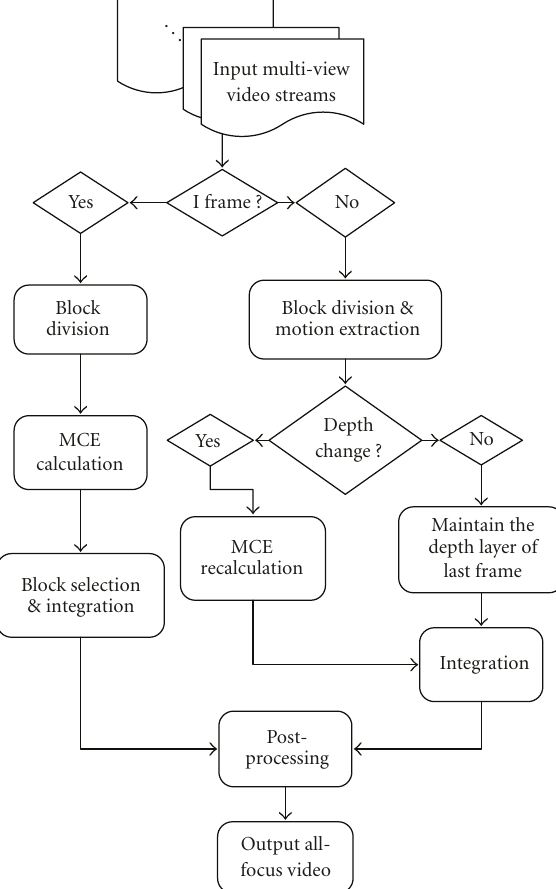
Figure 12: Flow chart of propose rendering